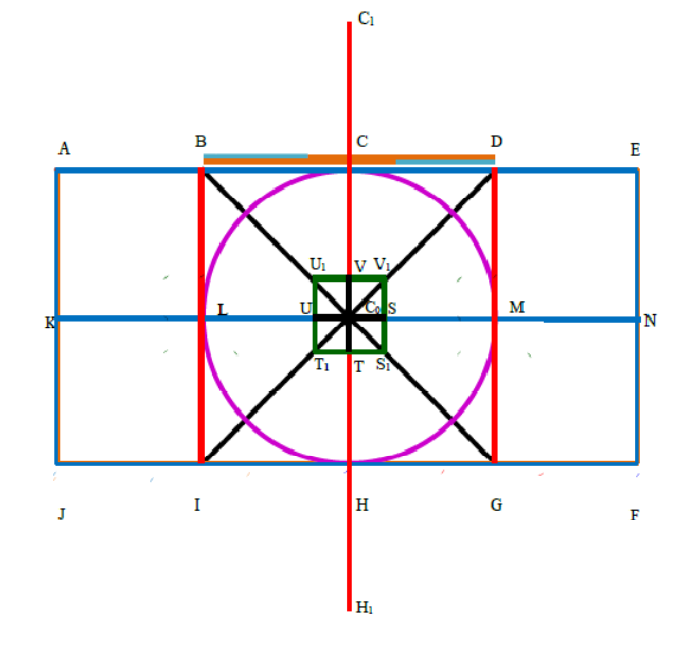
Figure 3. Golden section with diagonal lines of